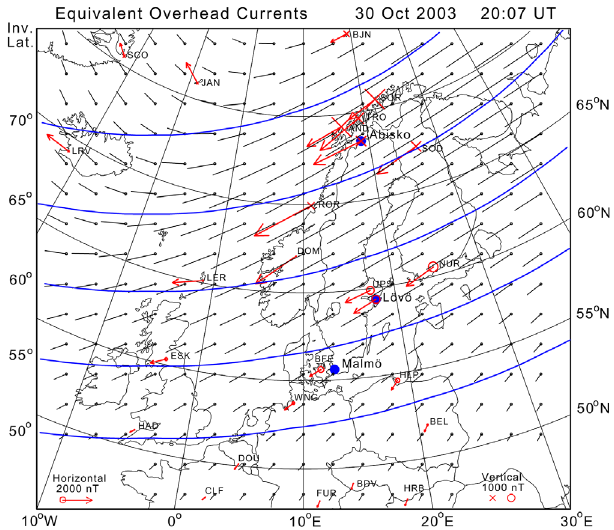
Fig. 5. Display of magnetic de fl ections measured at a range of observatories. The horizontal variation vectors have been rotated 90 (cid:3) CW to illustrate overhead current directions. The display of measured magnetic vectors has been supplemented by interpolated values of the horizontal vector component in a regular pattern. (modi fi ed from Stauning,